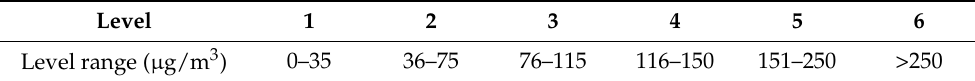
Table 2. PM2.5 and PM10